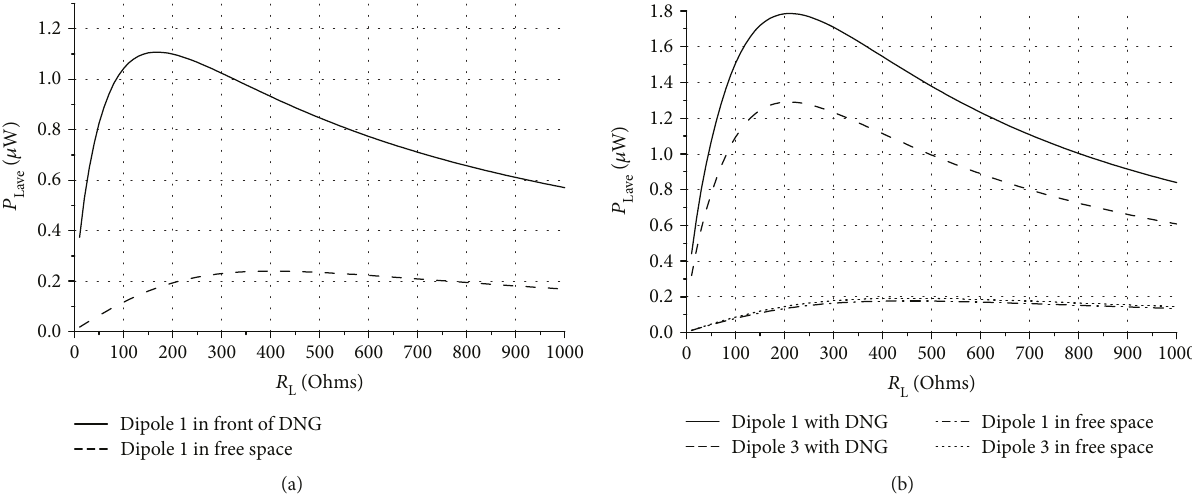
R L for dipoles with and without DNG slab. (a) Only one dipole.